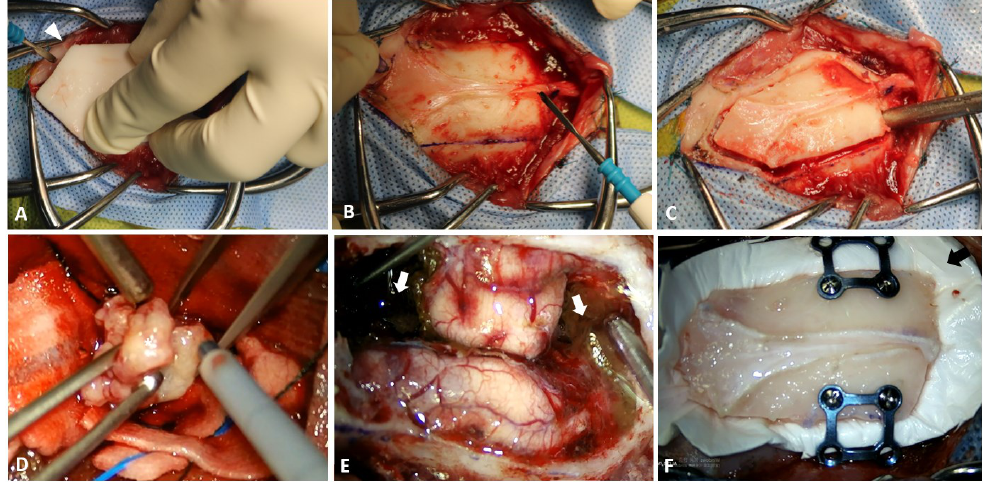
Figure 3. Application of three-dimensional (3D)-print guide (arrowhead) and surgical procedure. ( A ) Application of 3D-print guide. After removing soft tissues attached to the frontal, parietal, and occipital bone, the 3D-print guide is placed on the calvaria. ( B ) The osteotomy line is marked with electrocautery following the 3D-print guide. ( C ) The bilateral extended rostrotentorial craniotomy is performed with a 2.0 mm burr and fine Kerrison rongeur. ( D ) Removal of meningioma is per- formed by ultrasonic surgical aspirator for en bloc resection with open-window technique of the meningioma. ( E ) After removing the meningiomas, to control hemorrhage, hemostatic gelatin sponge and hemostatic matrix (white arrow) are used. ( F ) Closure of the cranium. To prevent cerebrospinal fluid leakage, artificial dura (black arrow) is used. The bone fragment is placed and secured to the skull with craniofacial plate and